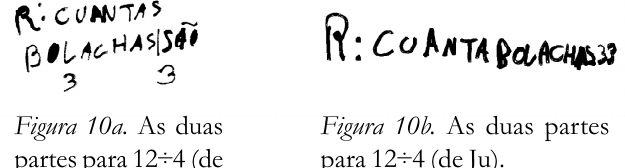
Figura 10a. As duas Figura 10b. As duas partes para 12(cid:247)4 (de